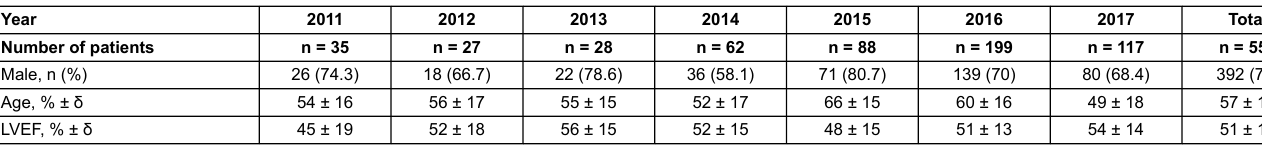
Table 1: Baseline parameters of patients undergoing cardiac magnetic resonance imaging in the years 2011–2017.